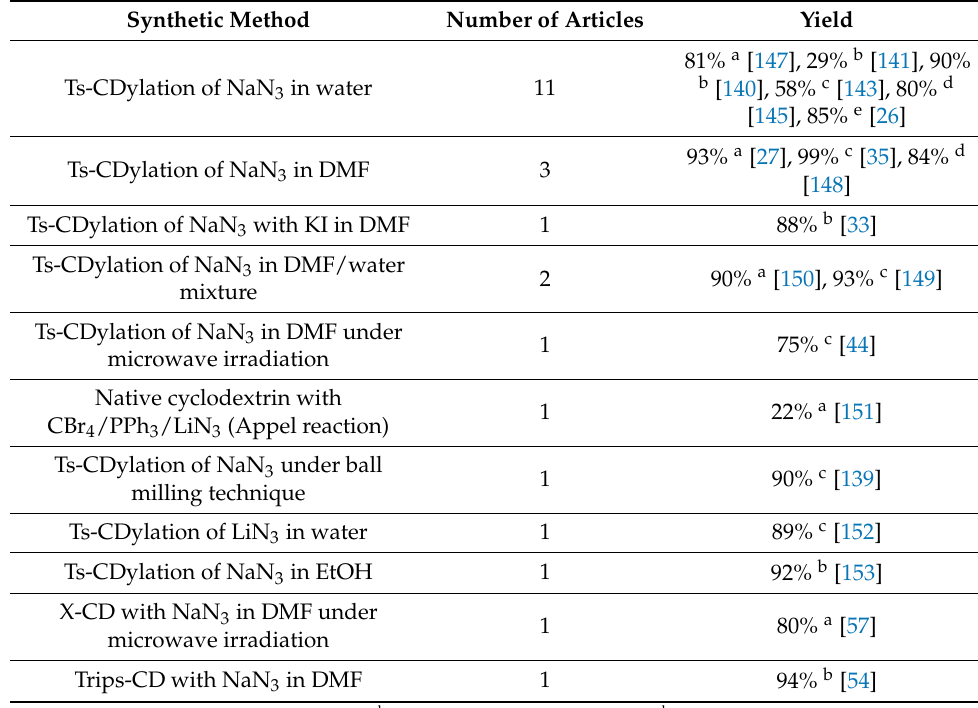
Table 6. Preparation of 6 A -deoxy-6 A -azides of CDs. Synthetic Method Number of Articles Yield Ts-CDylation of NaN 3 in water